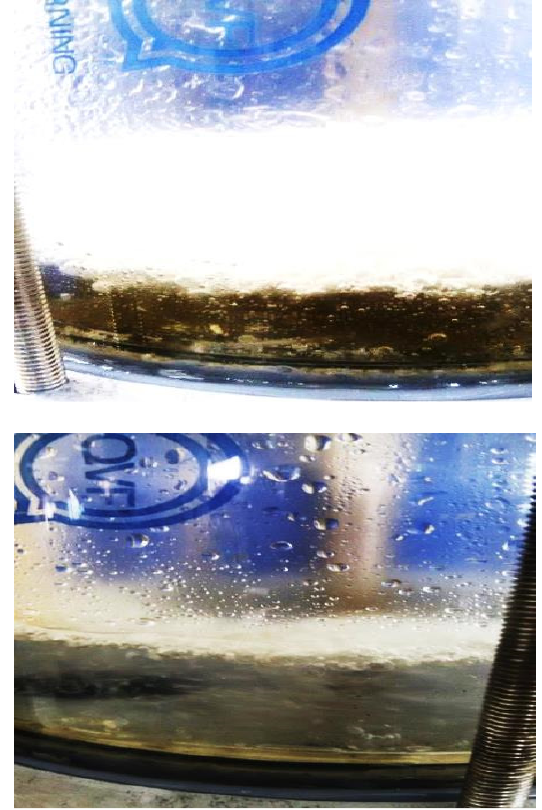
Fig. 6. Hydrate formation and disassociation for the R134a and water